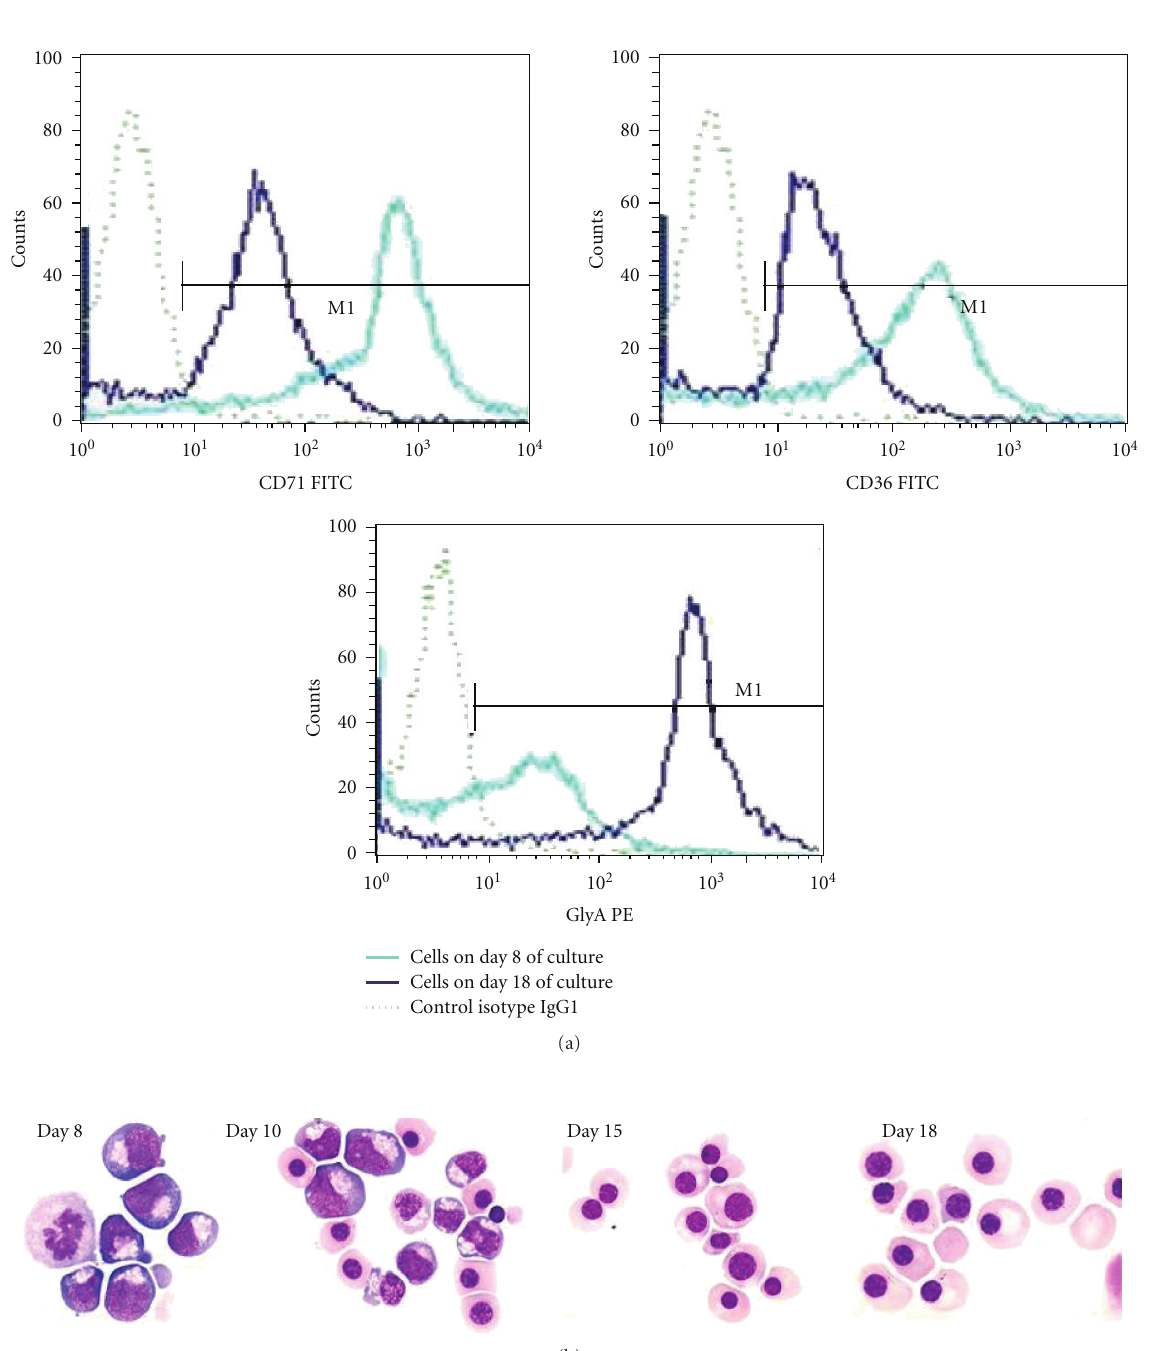
was detected and could be identified as Bart Hb, which corresponds to the association of four γ globin chains.